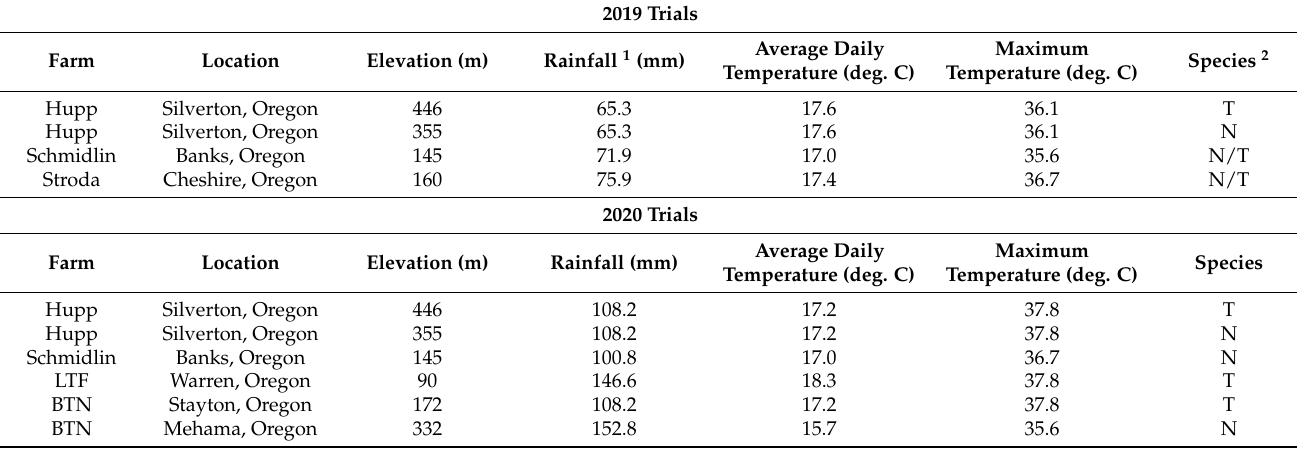
Figure 2. Applying S-ABA to a Turkish fir leader using the Easy Roller applicator. The test sites used in the experiment were all second or third rotation Christmas tree plantations and represent a broad range of growing environments within the Willamette Valley in Oregon. Specific site characteristics including elevation and weather during the period of shoot elongation (May–July) are summarized for each site and year in Table 1. Table 1. Christmas tree plantation locations and weather during the period of shoot elongation (May–July) for 2019 and 2020 S-ABA trials.